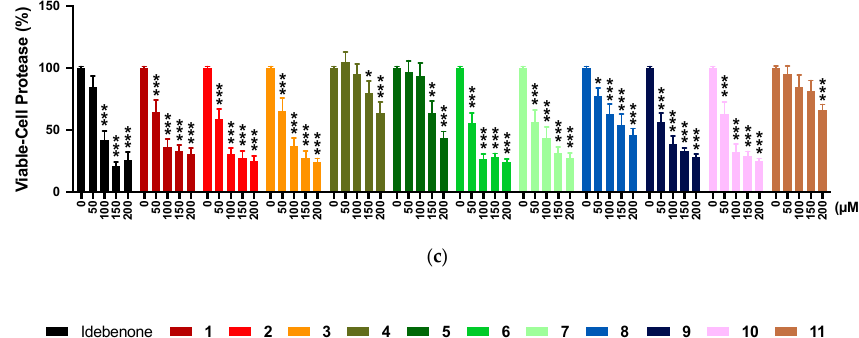
Figure 2. Effect of test compounds on membrane integrity. Cells were exposed to reference or test compounds (0–200 μ M) for 24 h before ( a ) propidium iodide (PI) incorporation; ( b ) necrotic-cell protease activity, and ( c ) viable-cell protease activity (Multi-Tox Fluor Kit) were assessed. Data represents mean ± SEM from 3 independent experiments with 4 parallel wells per experiment. Two-way ANOVA was performed to compare test concentrations against the non-treated control: *** p < 0.001, ** p < 0.002, * p < 0.033. Full datasets shown in Tables S4–S6. RFU, relative fluorescence